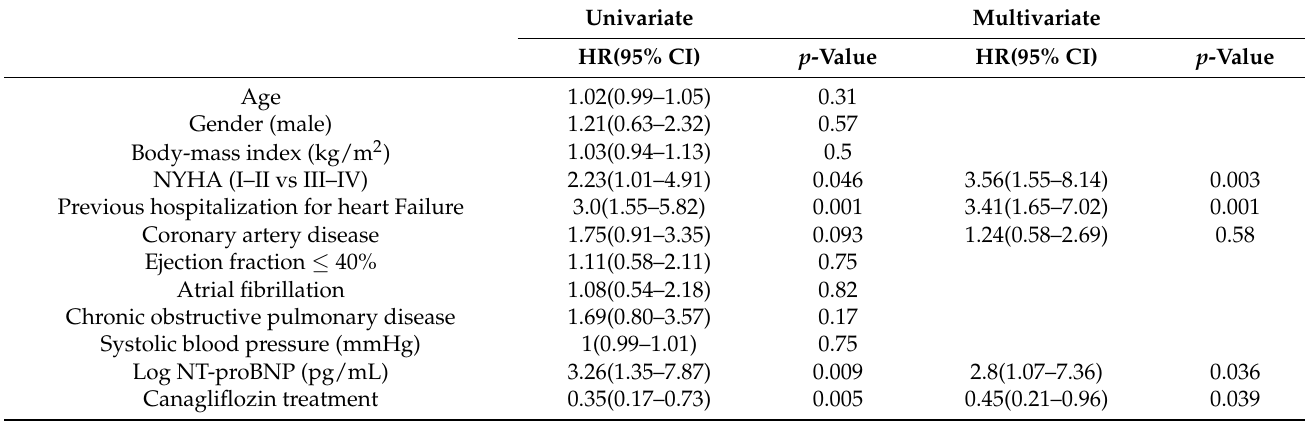
Table 3. Univariate and multivariate cox regression analysis for risk factors for readmission due to heart failure at first year. Univariate Multivariate HR(95%